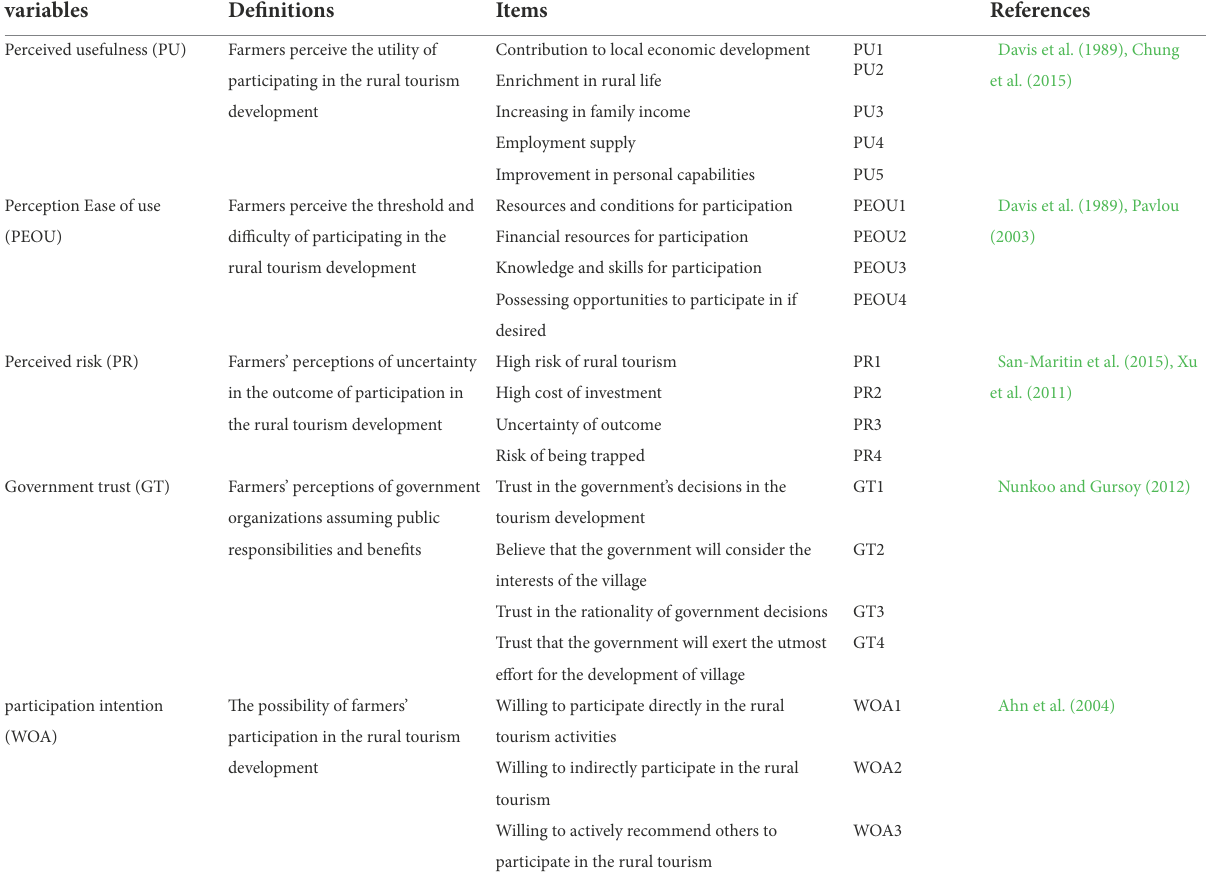
TABLE 2 Respondent’s profile ( N =